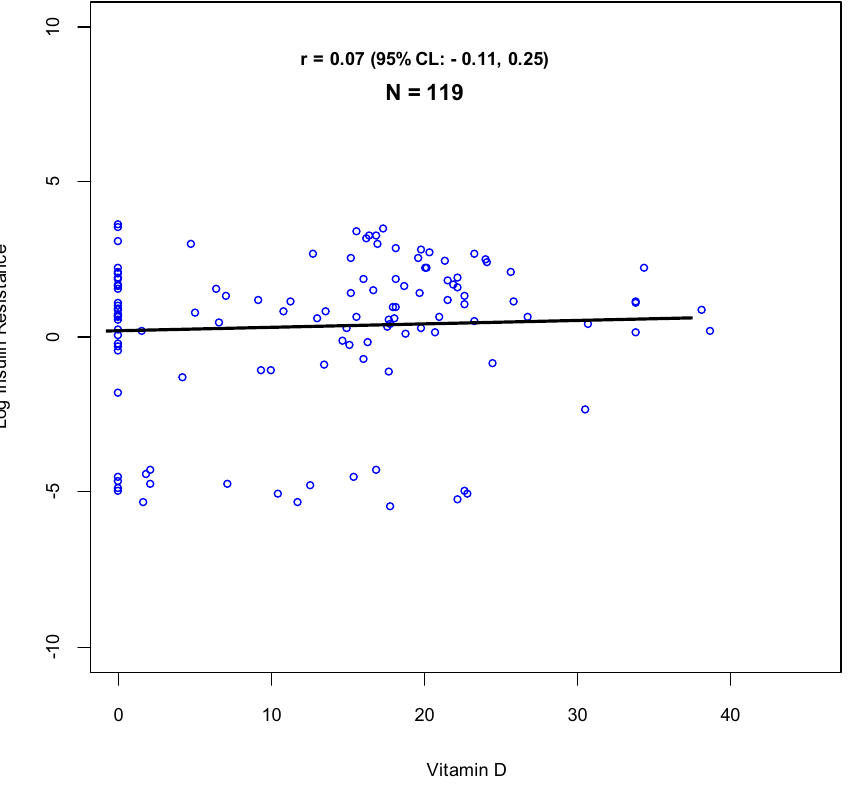
Figure 3. Relationship between vitamin D and log insulin